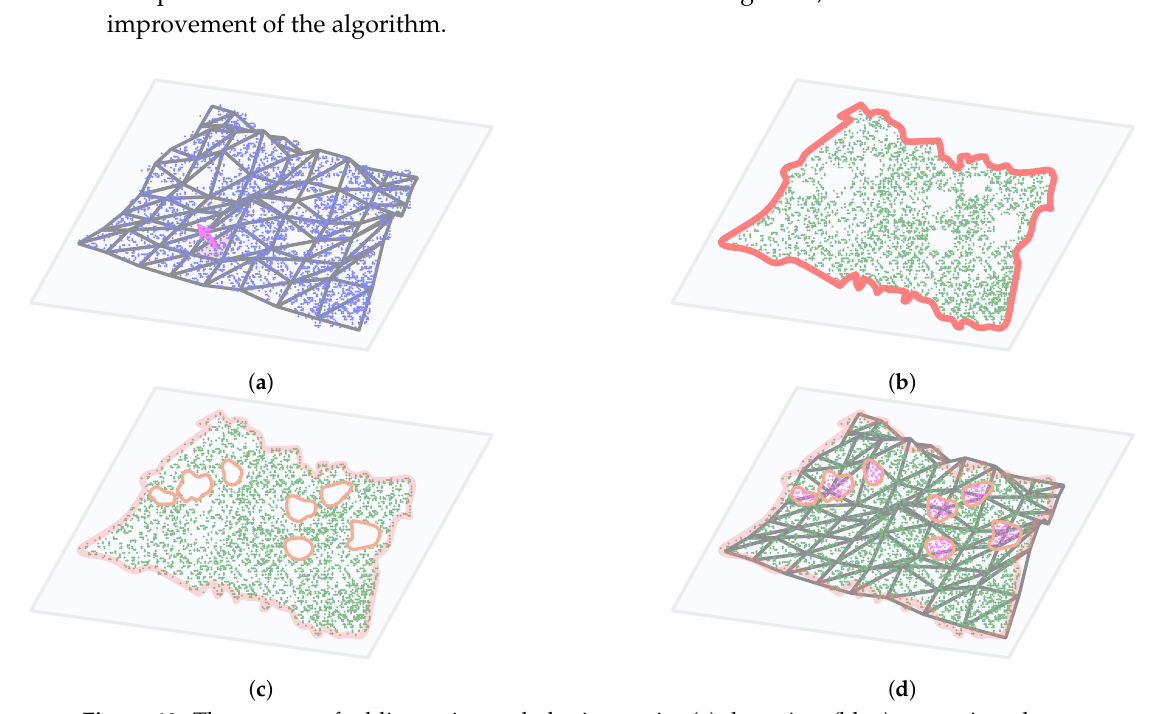
Figure 10. The process of adding points to holes in terrain: ( a ) the points (blue) are projected onto a DTM tangent plane (light blue) defined by the surface normal (pink), ( b ) Outline of the projected points (green) is calculated (red), ( c ) holes in terrain are identified (orange), and ( d ) holes are filled and reprojected back into 3D